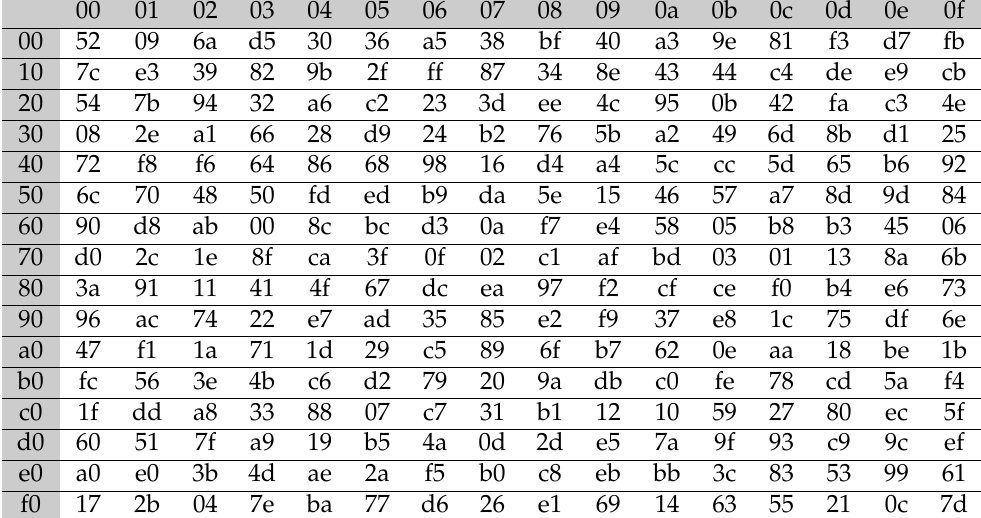
Table A2. Inverse Sbox in the AES block cipher.